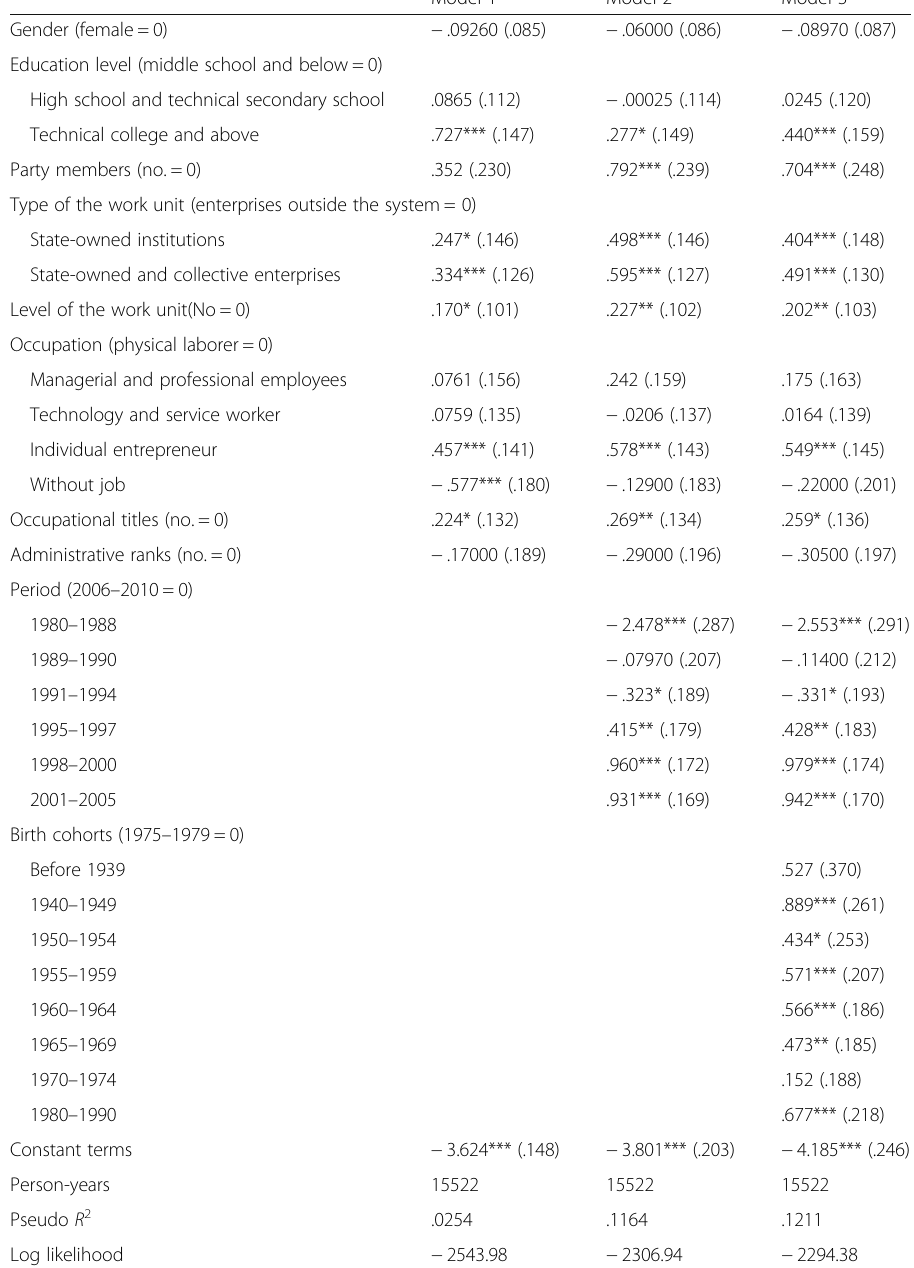
Table 2 Discrete-time event history analysis of housing property rights acquisition (1980 –